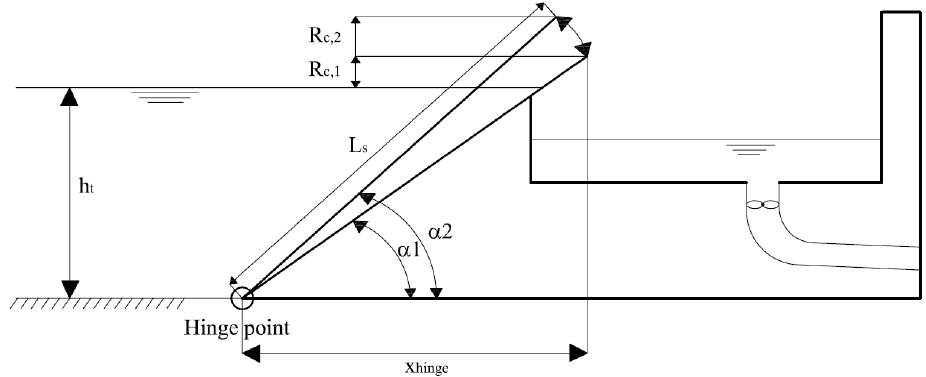
Figure 7. Scenario 5—Geometry control by installing a hinge point at the bottom of the slope—determining parameters